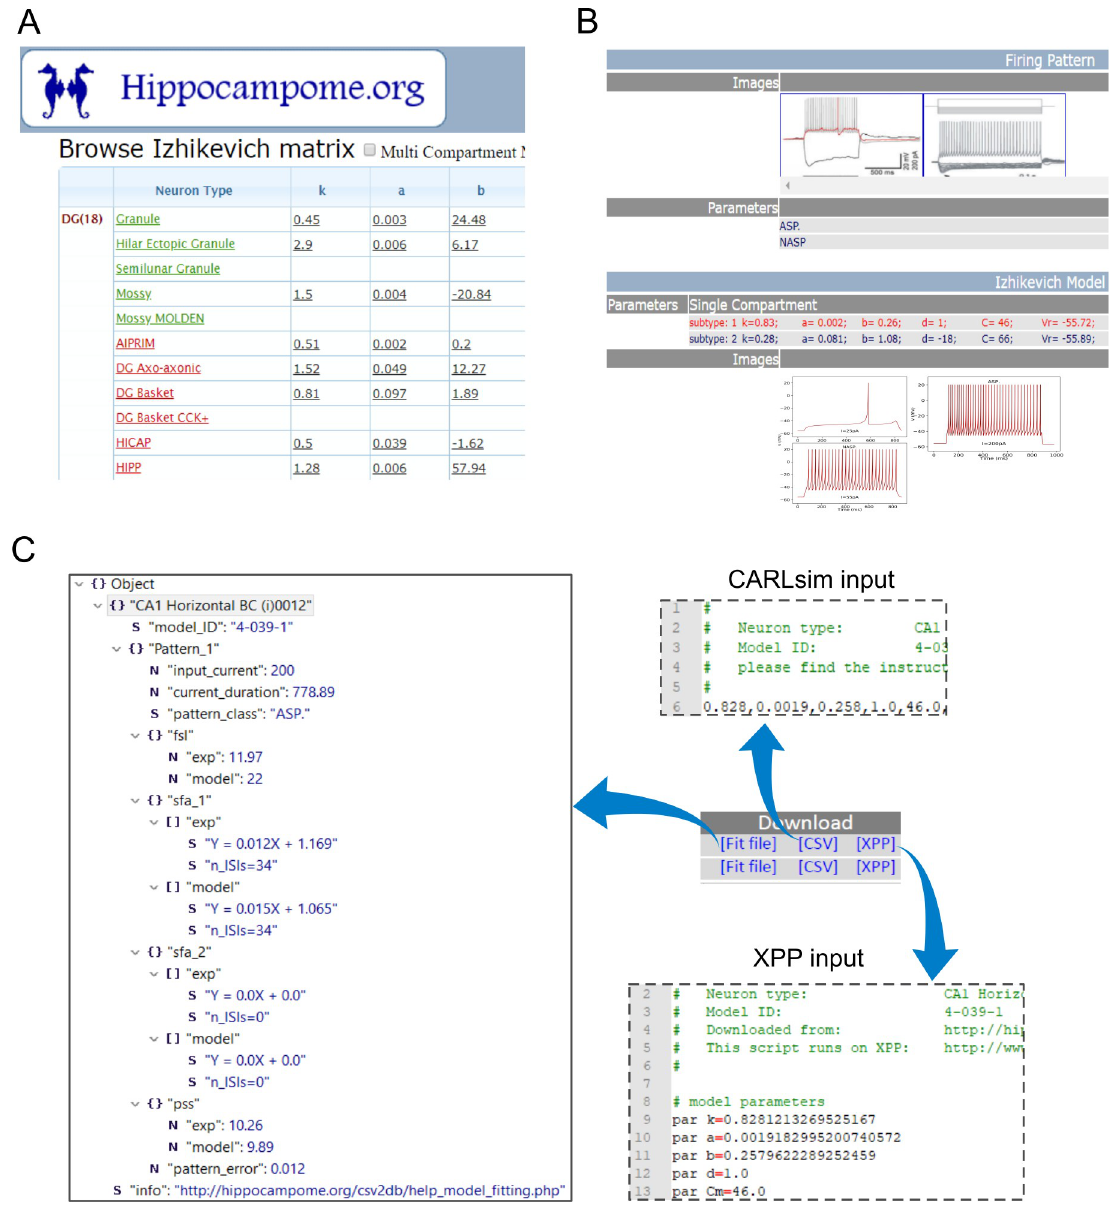
Fig 7. Hippocampome.org provides a comprehensive list of models and ready-to-run scripts. (A) Single- and multi-compartment model parameters for all neuron types are presented in a matrix form on the main page. Each row is linked to a Neuron page. ( B ) The Neuron page for each neuron type has been enhanced to include model parameters and simulated traces for all types and subtypes (if any). ( C ) The Neuron page provides the user with three downloadable files for each subtype: a Fit-file that lists both experimental and simulated features for each pattern, an XPP script to simulate single-compartment models, and a CARLsim input file for single- and multi- compartment